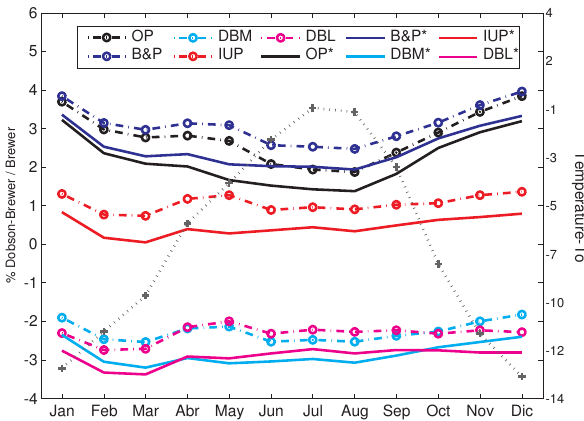
Fig. 10. Monthly means of the Brewer-Dobson differences for the Arosa observations. The different plot lines are derived from ozone calculated using the operational (fixed temperature) algo- rithms (black lines), and ozone calculated with temperature- de- pendent algorithms (colored lines). The dotted lines are for single- monochromator Brewer instruments and the solid lines are for dou- ble monochromator Brewer instruments. The effective stratospheric temperature difference between the nominal used in the algo- rithm and the temperature determined from the Payerne ozonesonde record is also displayed (gray dotted line with gray plus signs).